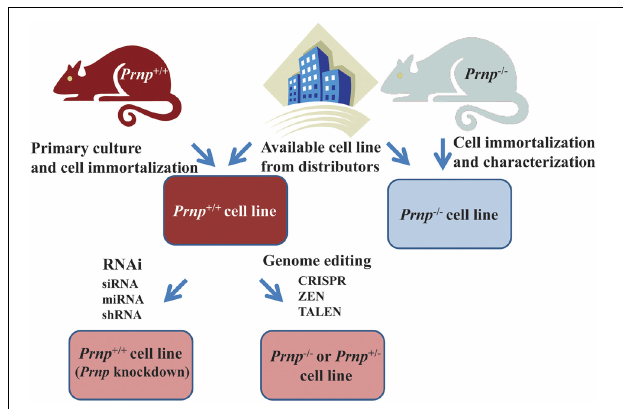
FIGURE 4 | Strategies for obtaining cell lines in which Prnp is suppressed or knocked out. Established Prnp − / − cell lines can be obtained from a number of distributors. If suppression of Prnp is required, rather than a knockout of Prnp , gene silencing technology using siRNA (small interference RNA), miRNA (micro-RNA) bi-shRNA (bifunctional short hairpin RNA) or shRNA (short hairpin RNA) is applicable. In other cases, when a new Prnp − / − cell line is generated, immortalization of cells derived from Prnp − / − mice is usually performed. Alternatively, gene editing techniques such as CRISPR (Clustered Regularly Interspaced Short Palindromic Repeat), ZFN (Zinc Finger Nuclease), or TALEN (Transcription activator-like effector nuclease) can be used to knockout Prnp , resulting in the production of Prnp + / − or Prnp − / − cell lines. Cells can be immortalized using oncogene transfection, radiation, fusion with cancer cells, or treatment with chemical mutagens. In other cases, cells derived from transgenic mice with an oncogene (e.g., temperature sensitive SV40 (Simian virus 40) large T, p53 etc.) that is overexpressed, mutated or deleted can proliferate and be maintained in culture medium. Continuous fibroblast culture can also be used. A cell line may be established after cloning and selection of these